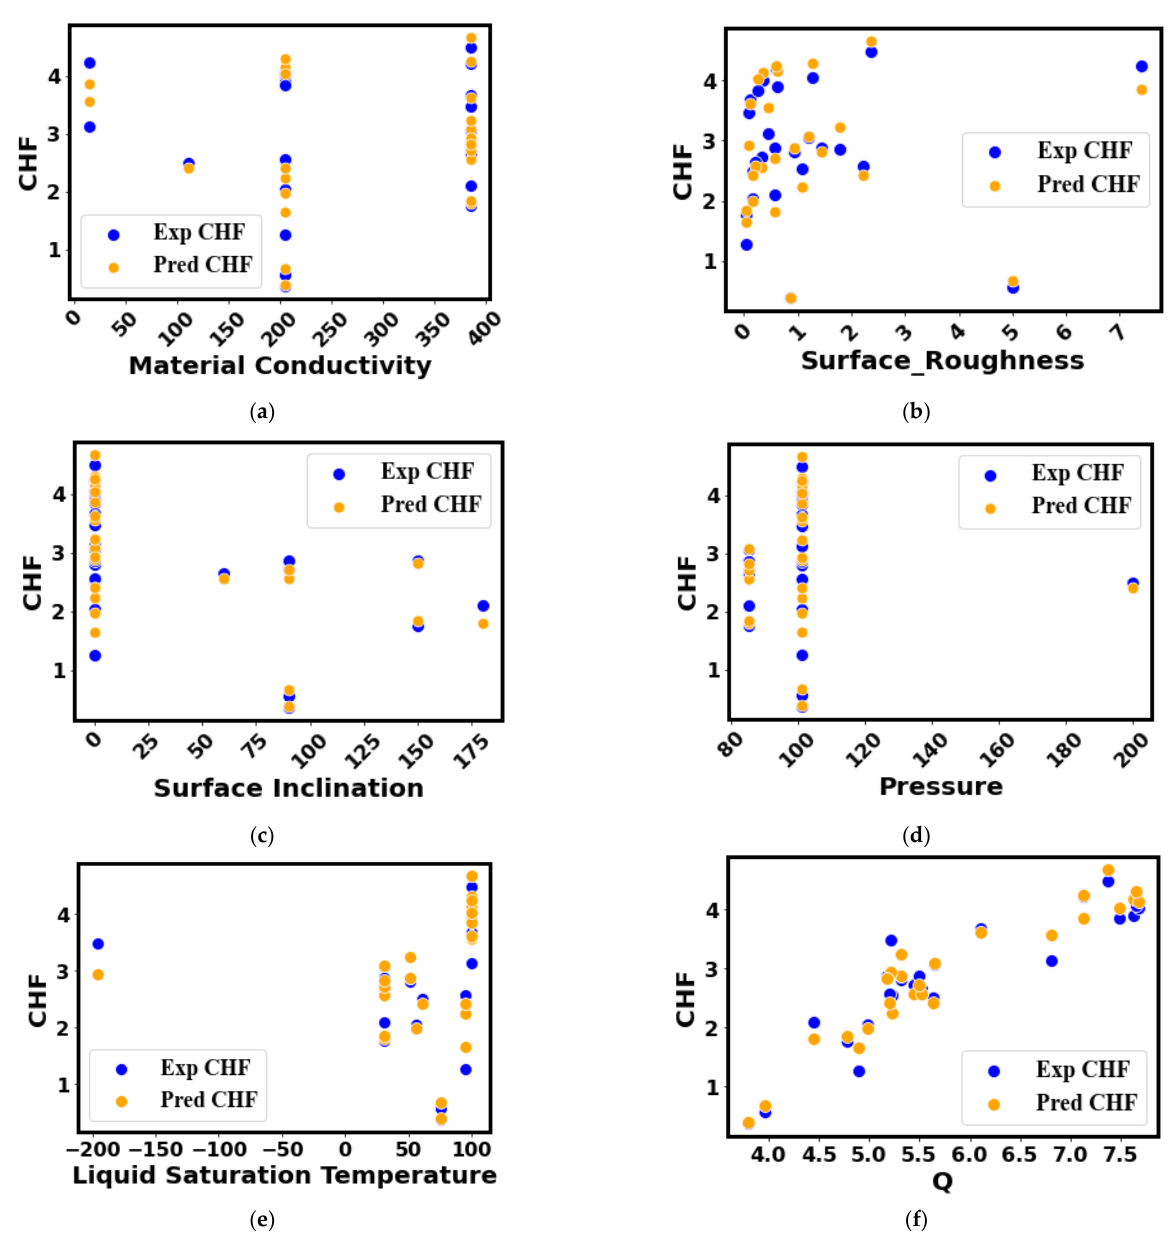
Figure 13. Prediction plots to assess the actual and anticipated data of the CHF with respect to the input parameters: ( a ) material conductivity, ( b ) surface roughness, ( c ) surface inclination, ( d ) pressure, ( e ) liquid saturation temperature, and ( f ) heat flux.